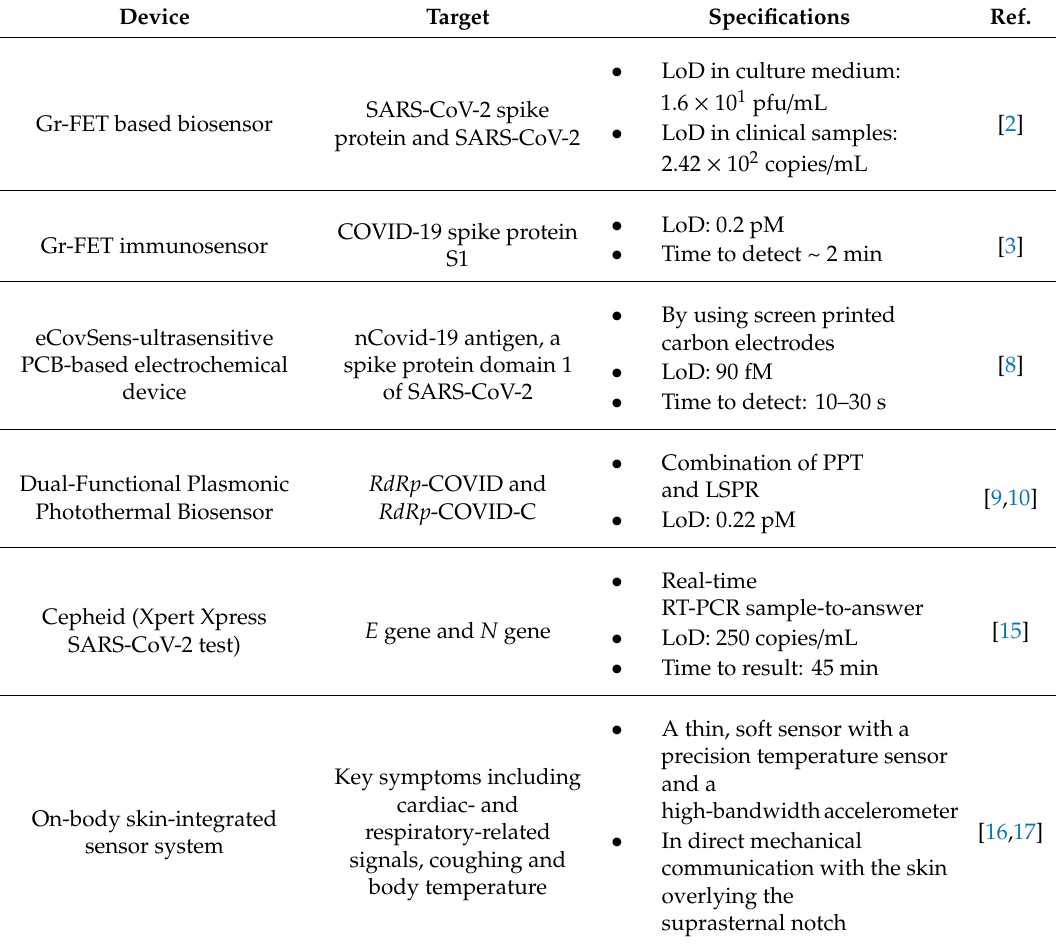
Table 1. Some of the reported devices for COVID-19